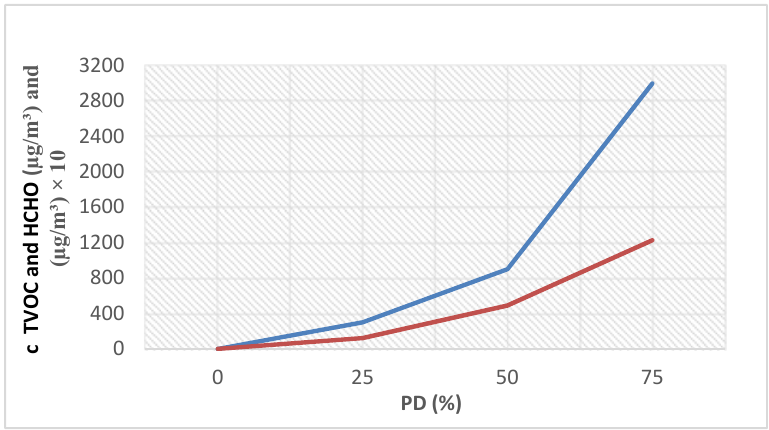
Figure 8. The percentage of persons dissatisfied function of TVOC (blue line) and HCHO (brown line) versus concentration.